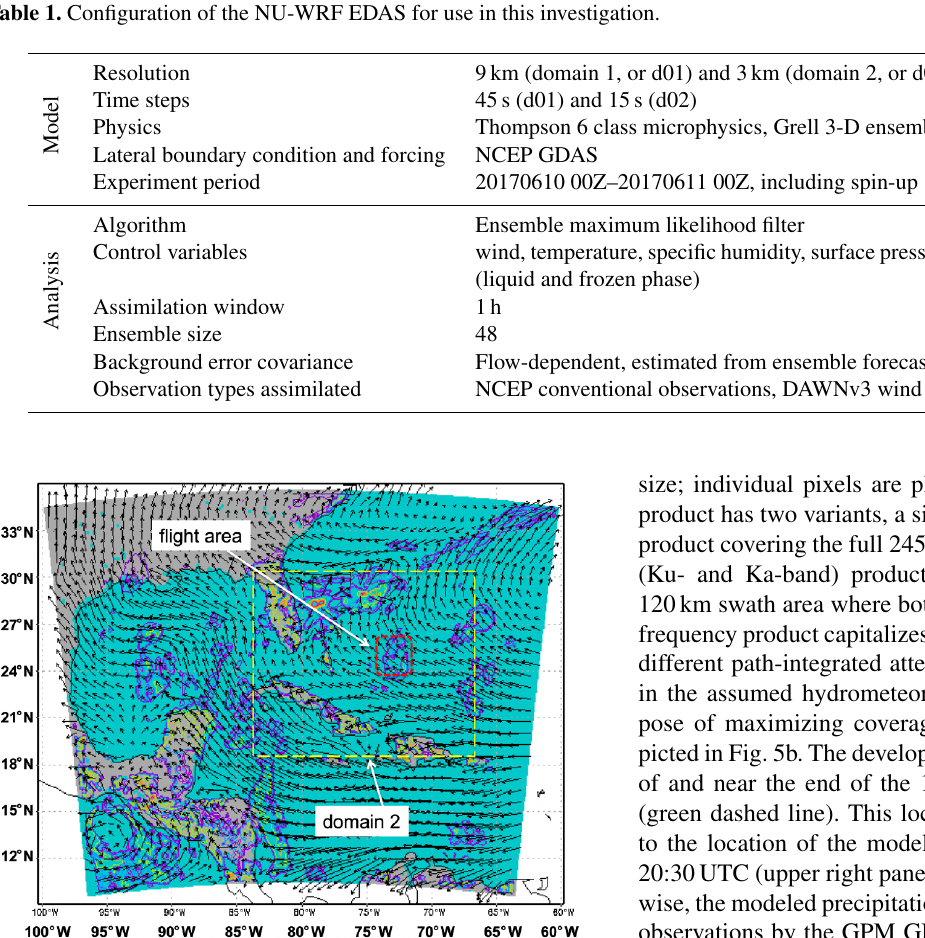
Figure 1. Depiction of NU-WRF domain 2; 10m winds are plotted from the control run at 19:00UTC. Domain 2 extends ∼ 18–30 ◦ N, 84–66 ◦